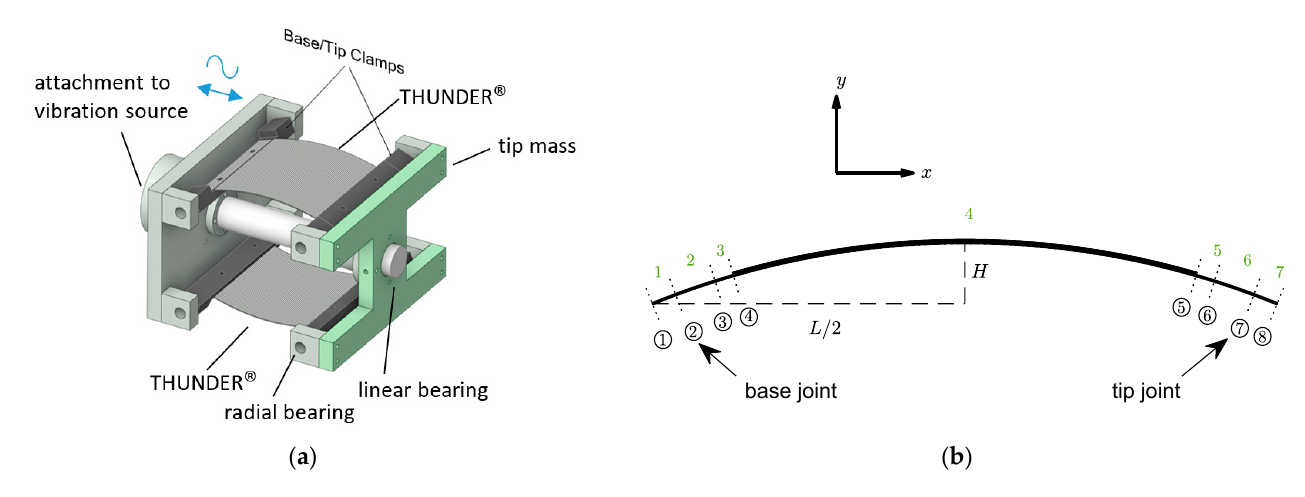
Figure 1. Vibration energy harvester: ( a ) 3D model of the assembly and ( b ) side view of one THUNDER device divided into five segments for analysis by DSM. Table 1. Properties used for THUNDER [32].